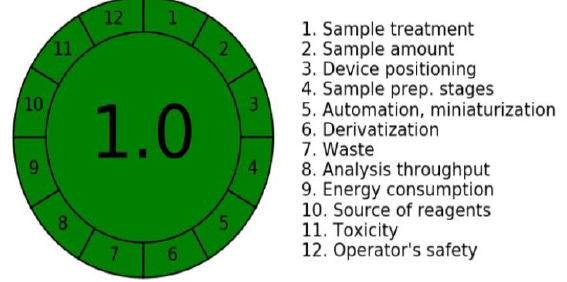
Figure 2. AGREE pictogram before weight modification.